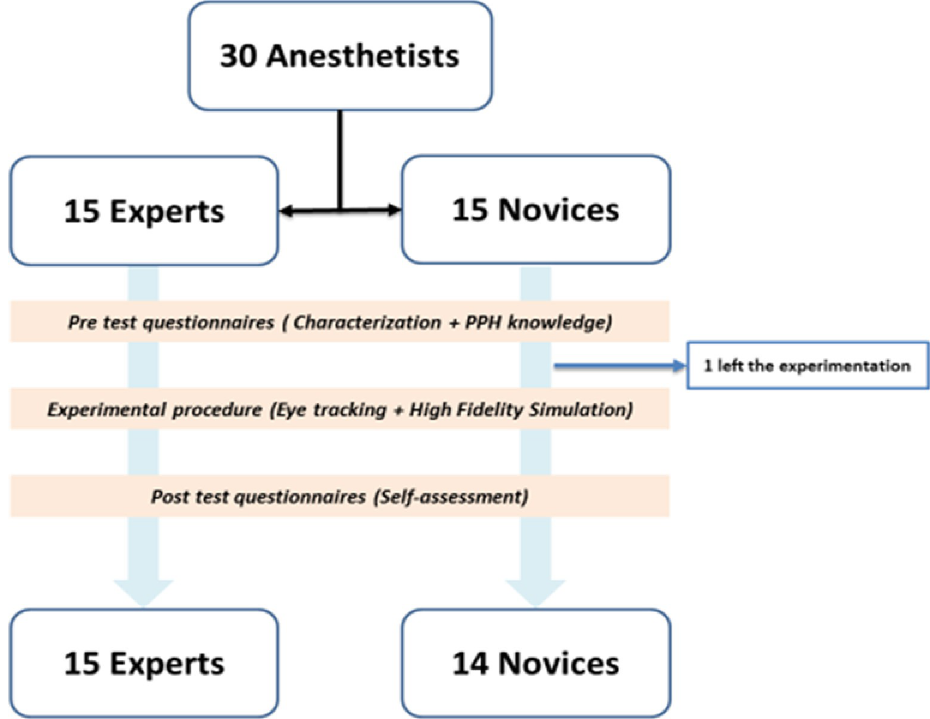
Fig 3. Experimental flow chart. 30 anesthetists participated in this experimental study. 15 experts with more than 5 years of experience. 15 novices with less than 5 years of experience. 1 novice left the experimental protocol before oculometry. The cumulative experience in maternity ward is significantly higher among Experts 12.1 ± 8.1 years versus 1.0 ± 1.7 years for Novices. Anesthetists’ level of theoretical knowledge on PPH is not statistically different between the groups (52.4% ± 3.5 of correct answers). The experts were confronted with more real PPH situation. They are 67% to have managed more than 50 cases and 27% more than 100 cases. Only 57% of the novices participated in the management of 10 to 50 cases for the most exposed ( p < 0 . 05 ). Participating anesthetists are familiar with high fidelity simulation since 67% of Experts (n = 10/15) and 87% of Novices (n = 13/15) have already practiced it. However, all the novices have already practiced PPH scenario while only 2 experts already did it ( p < 0 . 001 ). None of them practiced eye-tracking experiment